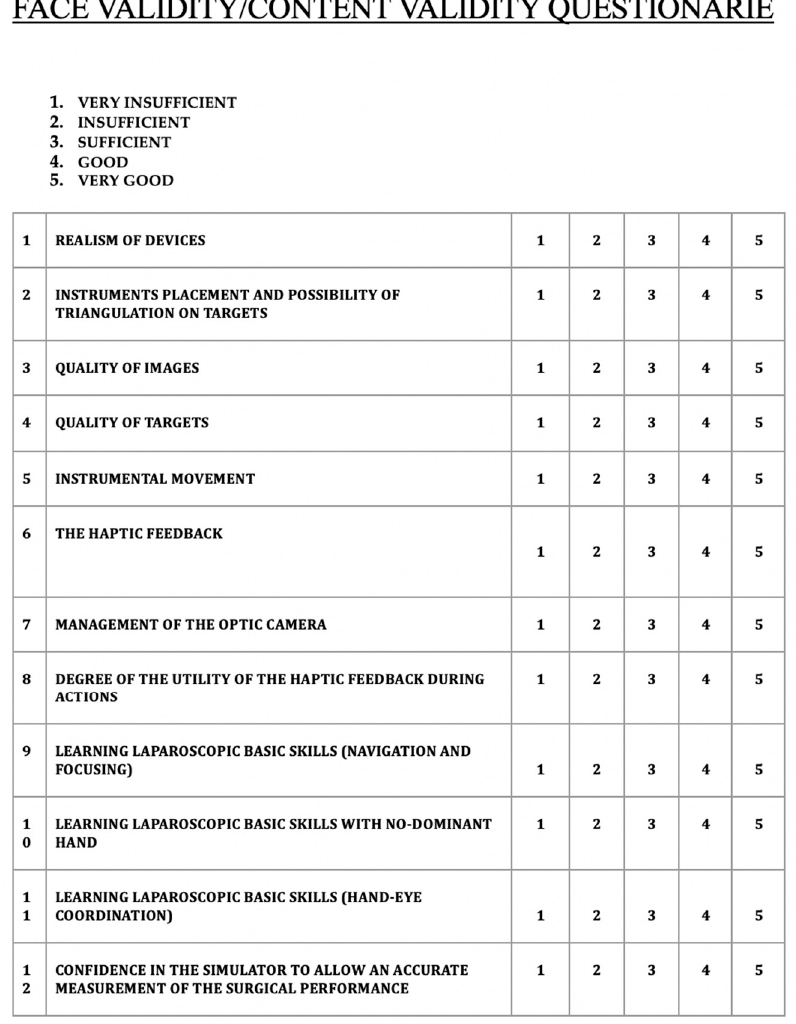
Figure 2. Questionnaire (five-point Likert scale) employed for face and content validities.